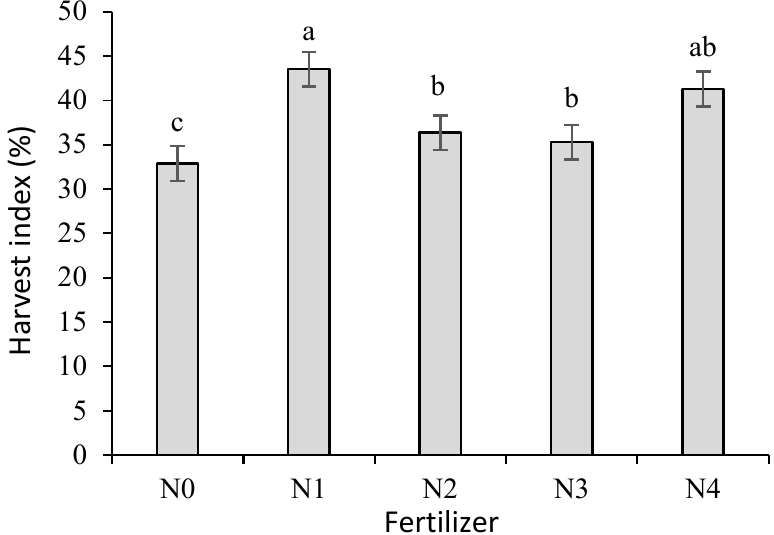
Figure 3. Harvest index of dill ecotypes affected by chemical and bio-fertilizer treatments. Different letters indicate significant difference at p ≤ 0.05 (Duncan test). Control (N0), chemical fertilizers (N1), Enterobacter cloacae S16-3 bacteria + half a chemical fertilizer (N2), Piriformospora indica fungi + half a chemical fertilizer (N3) and combination of bacteria + fungi + half a chemical fertilizer